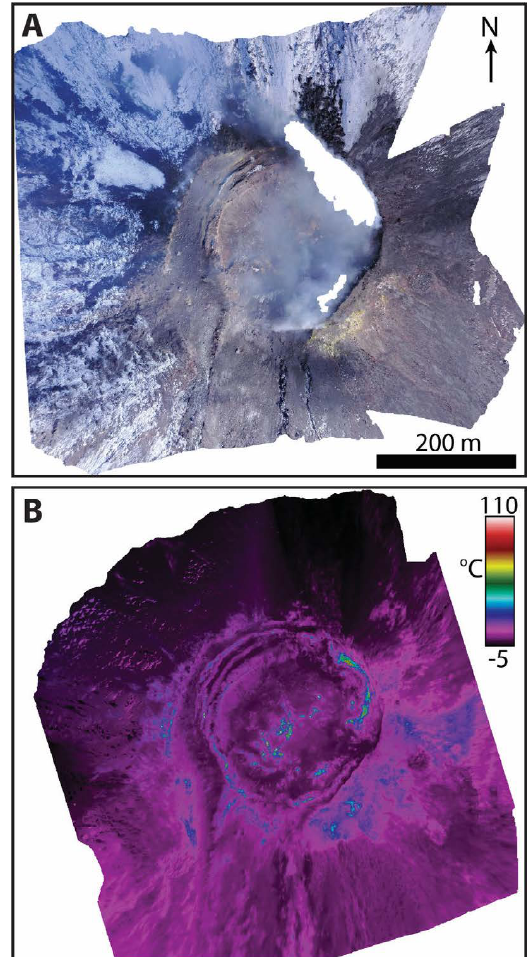
Figure 4: Vertical views of 3-D models of the sum- mit lava dome at Volcán de Colima, Mexico con- structed from quadcopter surveys (2018). [A] A visible- wavelength survey using 58 photographs acquired us- ing a Mavic Pro and [B] 195 thermal images acquired with a FLIR TAU2 thermal camera on a Phantom 4 Pro. Both surveys were carried out at ~120 m above ground, with the higher-resolution visible data resulting in a model resolution of ~7.3 cm, compared to ~40 cm for the lower-resolution thermal data. Note that the visi- ble data did not enable successful modelling of some areas which were obscured by degassing plumes (e.g. the NW-oriented white area of the NE crater wall area), whereas the thermal data provided full topographic